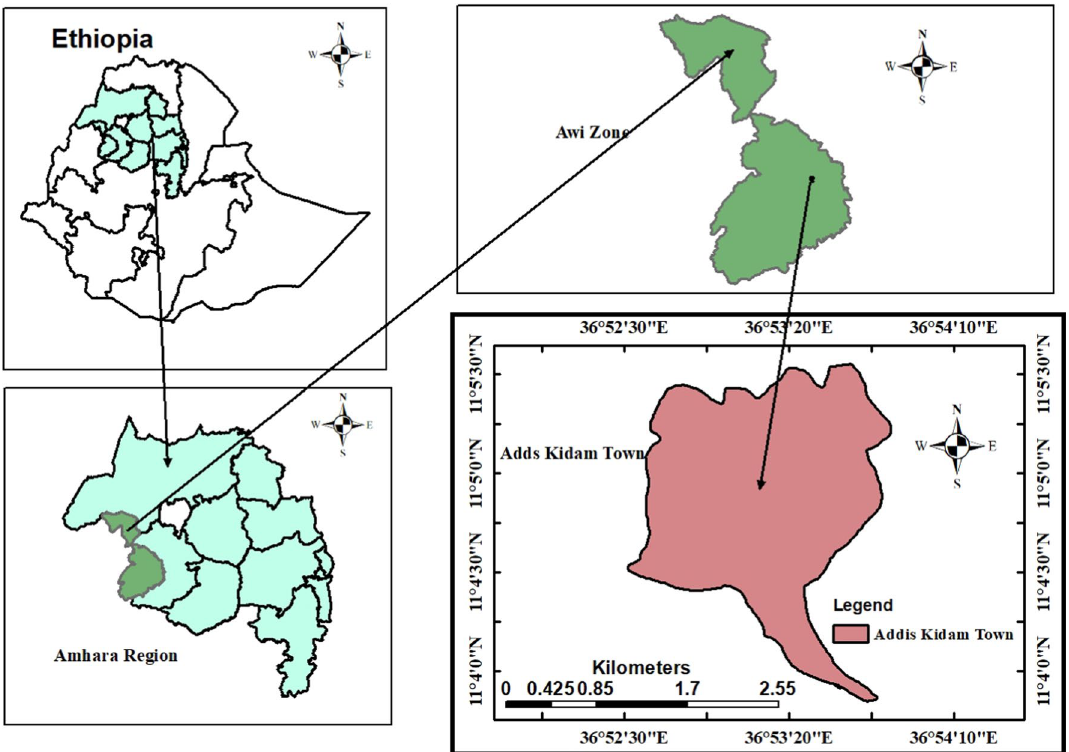
Fig. 1 Map of the study